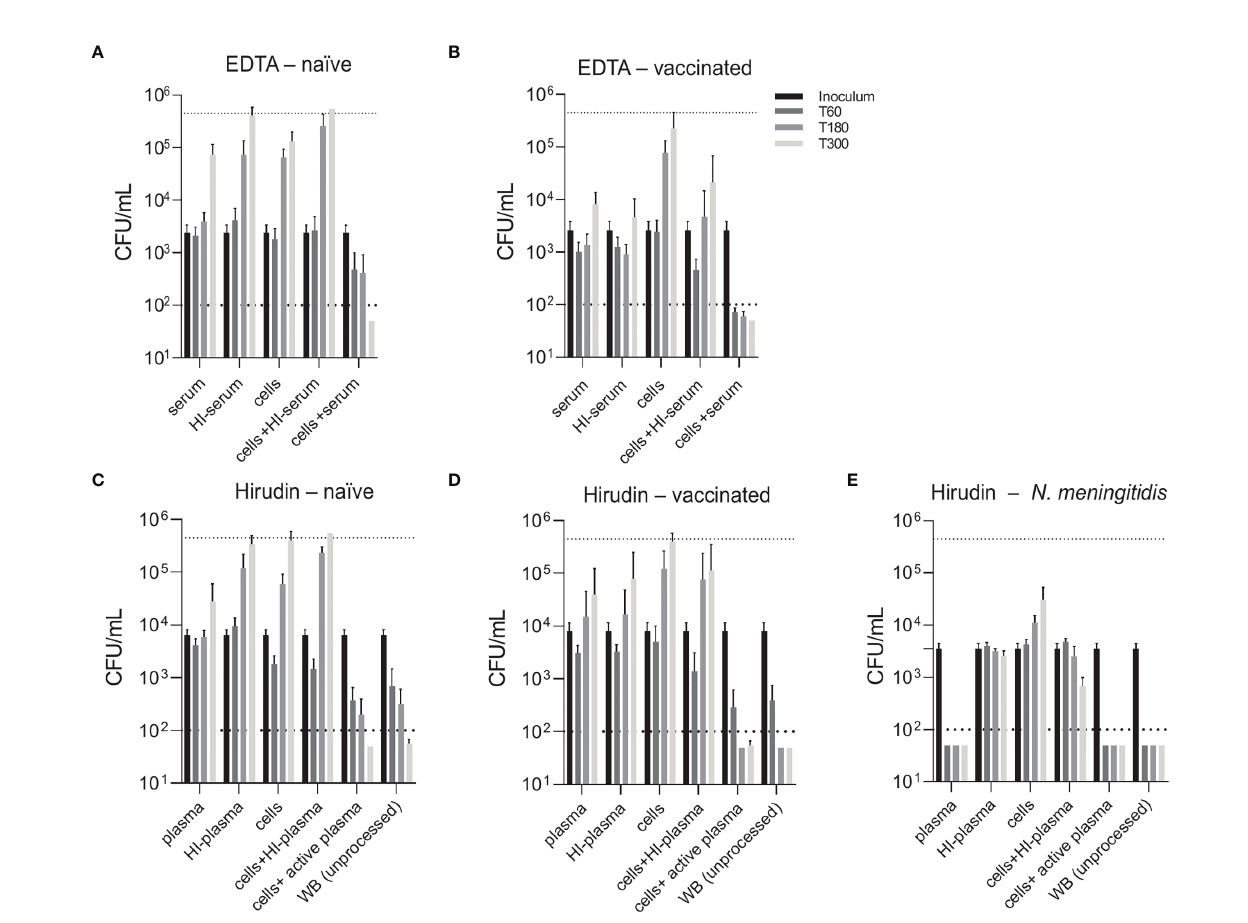
FIGURE 3 | Contribution of active complement and antibodies to opsonophagocytic killing of pneumococci. Pneumococcal killing was assessed in either an assay based on DPBS-washed cells from EDTA-anticoagulated blood reconstituted with active or HI serum [EDTA assay; (A, B) ] or in a hirudin-anticoagulated whole blood (WB) assay [Hirudin assay; (C, D) ] comparing vaccine-naïve (A, C) and PCV13-vaccinated individuals (B, D) . Cumulated results for all individuals per group are shown. Meningococcal killing in hirudin-anticoagulated whole blood of a MenACWY-vaccinated volunteer (E) served as a control for direct killing by the MAC. Bars indicate CFU/mL at start of inoculation and 60, 180 and 300 minutes after inoculation. Dashed lines demonstrate the lower detection limit ( < 100 CFU/mL) and the upper limit ( > 500 ’ 000 CFU/mL) for exact quanti fi cation. WB, whole blood; HI,